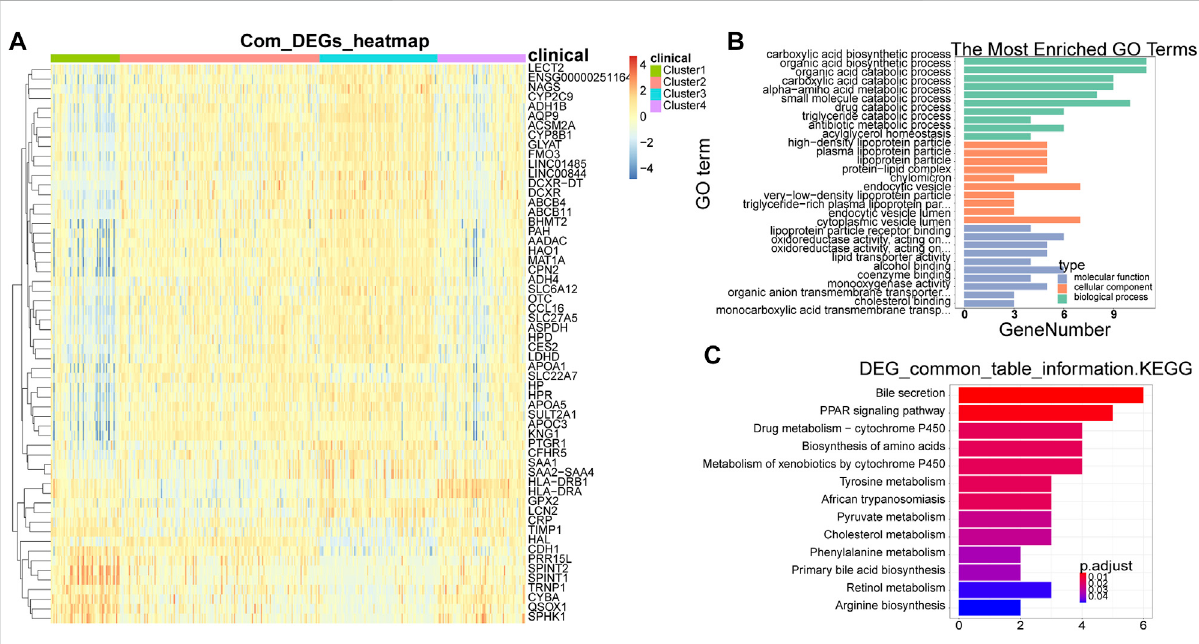
FIGURE 3 Identi fi cation and enrichment analysis of common DEGs. (A) Heat map of common DEGs among different subtypes. Each small square represents each gene, and its color indicates the expression level of the gene. The larger the expression level, the darker the color is (red is high expression,blueislowexpression). (B) ThemostenrichedGOtermsaresummarized. (C) BiologicalProcessesbarplot.Theordinaterepresentseach biological item, the abscissa represents the gene proportion, the color of the dot represents the p -value, the redder represents the higher con fi dence, the size of the dot represents the number of genes involved, and the larger the dot represents the more genes involved. DEGs, differentially expressed